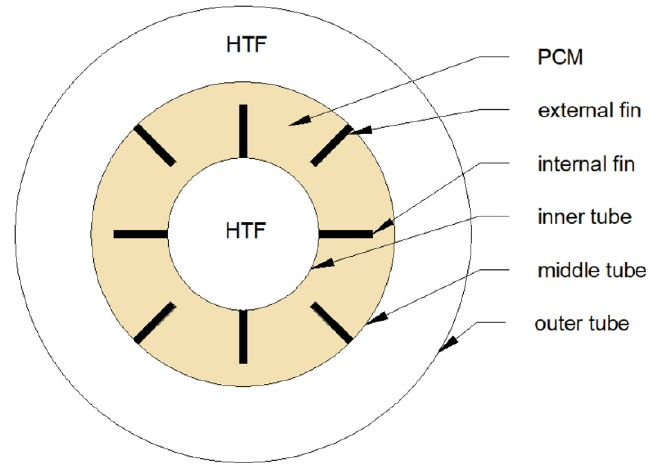
Figure 12. Cross-section of a TTHX with a possible arrangement of longitudinal fins [112].